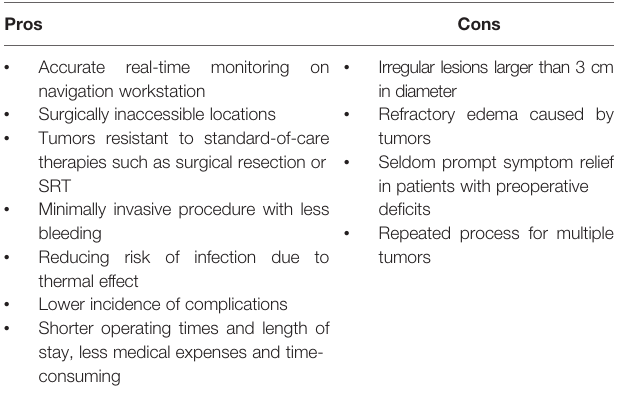
TABLE 3 | Pros and cons of the LITT in comparison to open surgery in patients with BM. Pros